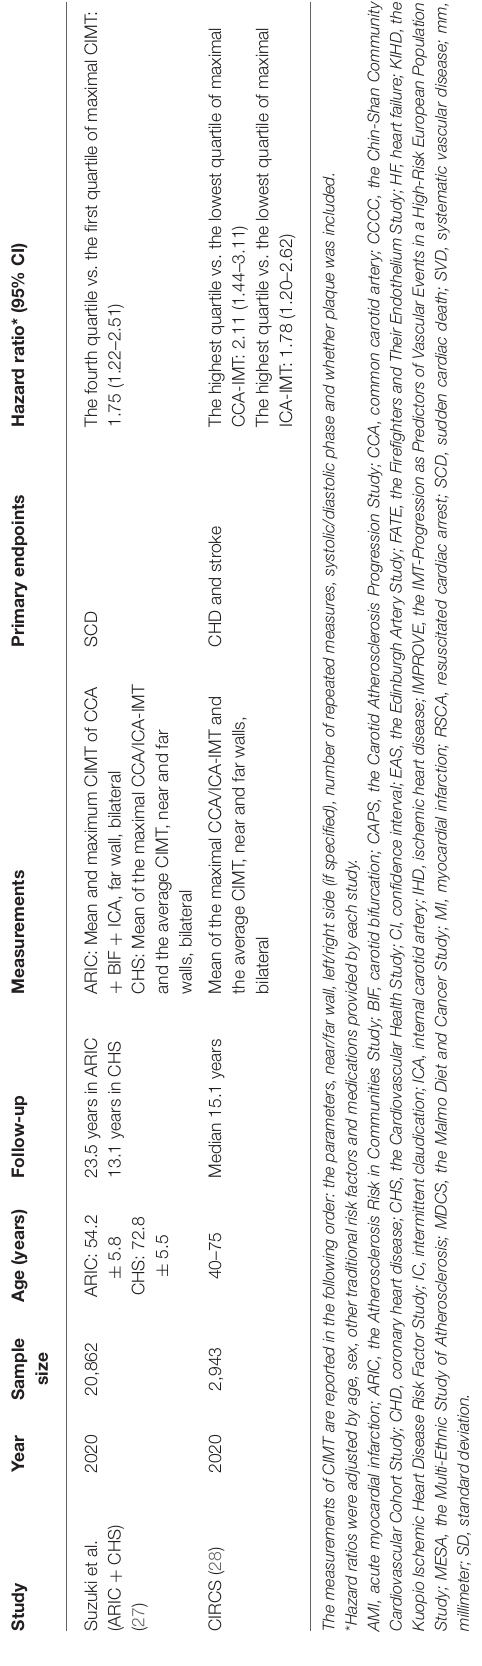
by the optimized R-wave (4). The accuracy of far-wall CCA-IMT measurements has been validated by the absence of a significant difference from in vitro specimens (30), while the near-wall measurements are less accurate due to liable artifacts. Three- angle scans of the CCAs help prevent an irregular CIMT from being inadequately evaluated without considering the near-wall CIMT. For instance, the far-wall CIMT of a 50-year-old man is clearly measured to be 0.8 millimeters (mm) in Figure 1A , while the CIMT of another 41-year-old man was significantly thicker, measuring 1.3 mm at the near wall in Figure 1B . In addition to CCA-IMT, significantly thicker CIMT values at carotid bulbs and ICAs should not be neglected, especially in patients with normal CCA-IMT values, to avoid underestimations of cardiovascular risk. The Mannheim CIMT and Plaque Consensus states that CIMT can be assessed at carotid bulbs and ICAs (31). A CIMT ≥ 75th percentile after adjusting for the patient’s age, ethnicity, and sex is recommended as an indication of an increased CVD